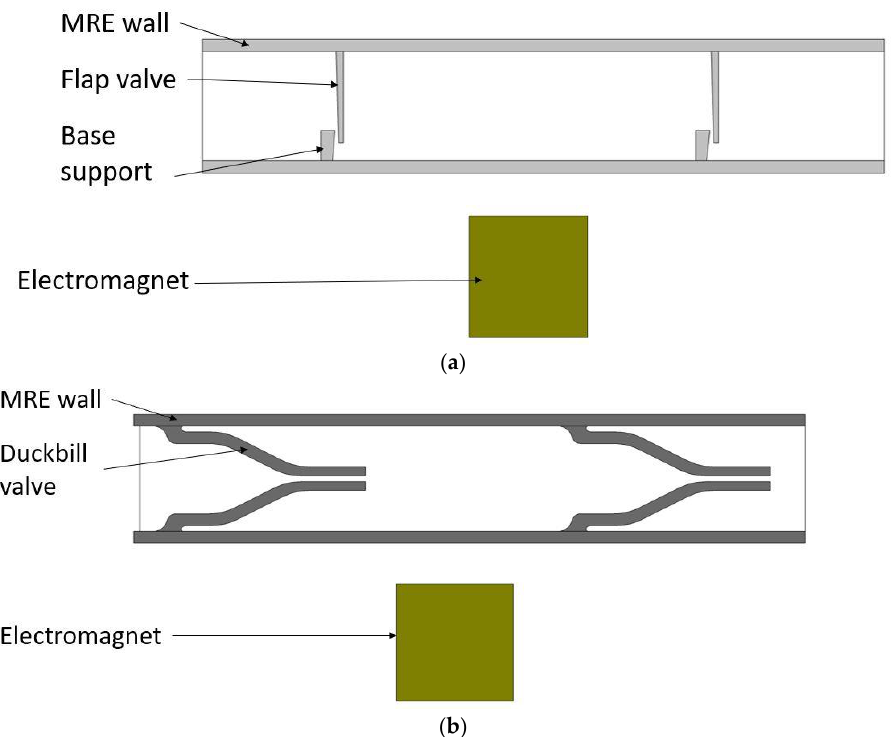
Figure 2. Micropump models with their main components: ( a ) flap valve model; and ( b ) duckbill valve model.